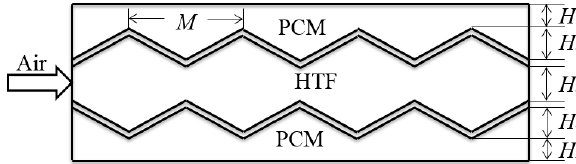
Figure 1. Physical configuration of the zigzag configuration. H : height; M: tooth length; PCM: phase ‐ change ‐ material; and HTF: heat transfer fluid. Table 1. Thermophysical properties of the NaCl ‐ MgCl 2 salt for the validation experiments. Density